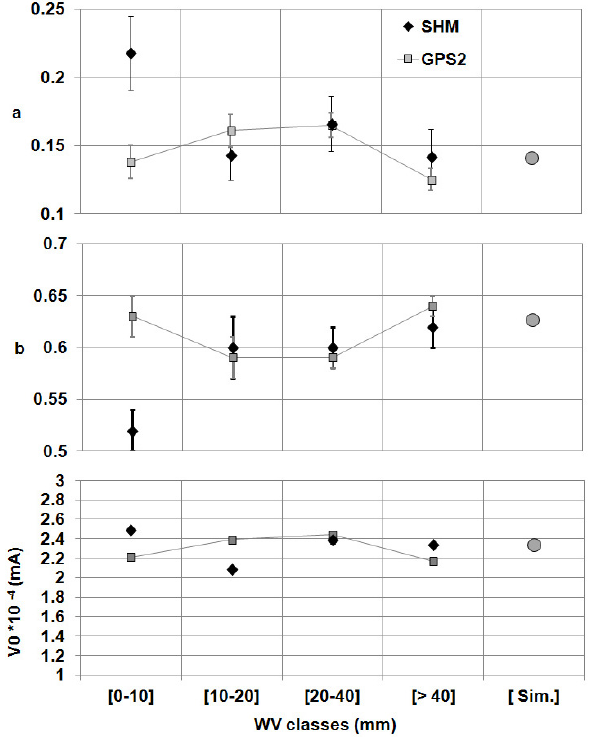
Fig. 4. Parameters a,b and V 0 as estimated by the presented methodology (black points), see Table 2. The grey circles refer to the retrieval obtained by a fitting procedure of a simulated transmit- tance.